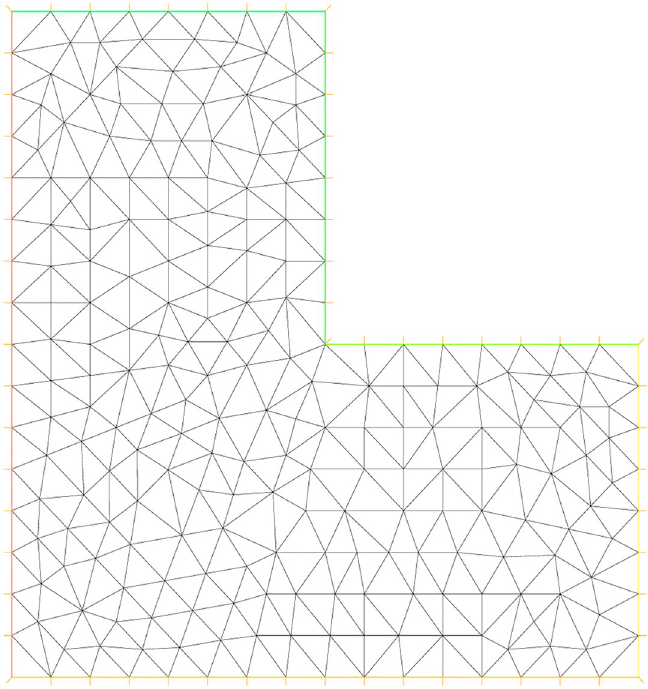
Fig 9. Initial adaptive mesh refinement for the L-shaped domain.